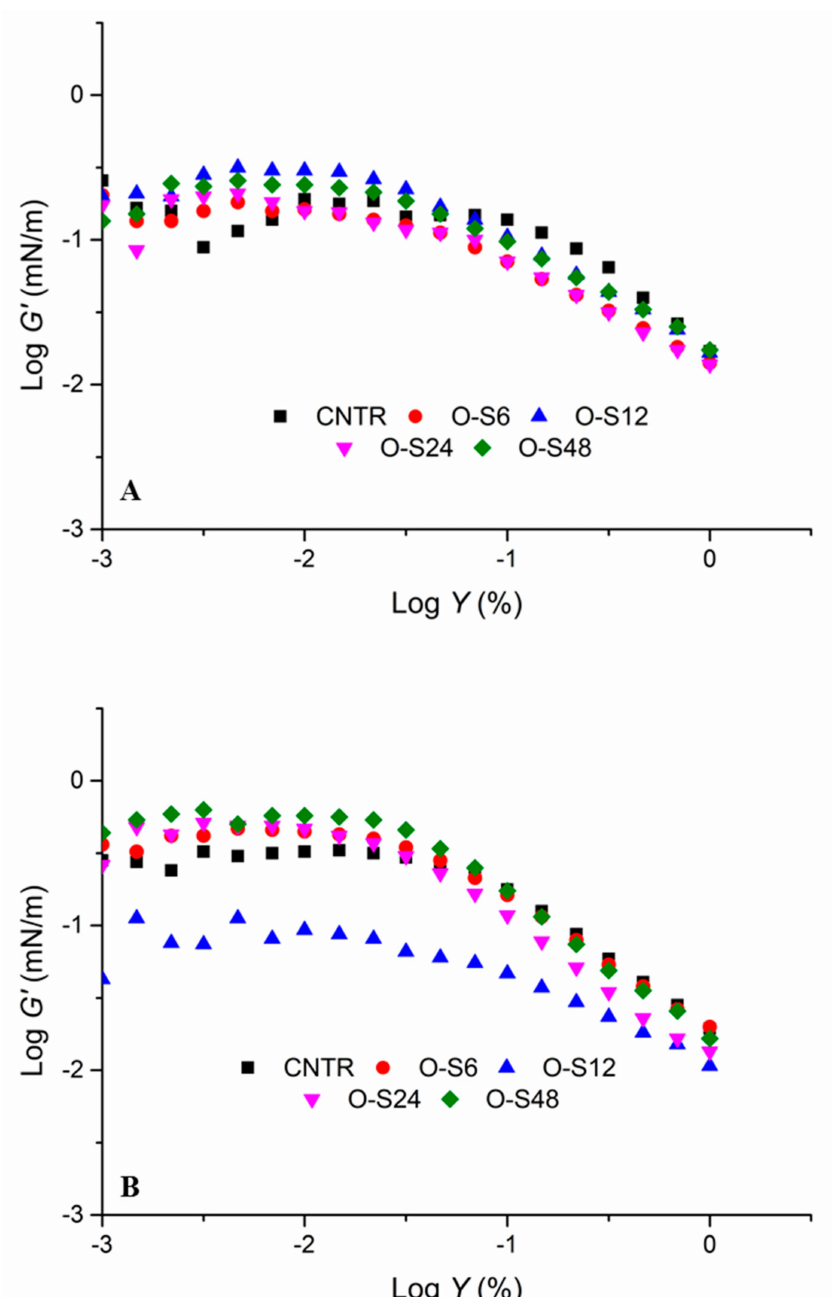
Figure 7. Strain dependence of interfacial storage modulus ( G (cid:48) ) of Pickering emulsions stabilized by ODF-SPI mixture (control = CNTR) and ODF-SPI conjugates by dry heating for 6 h (O-S6), 12 h (O-S12), 24 h (O-S24) and 48 h (O-S48) with oil / water ratios of 1:2 ( A ) and 1:3 ( B